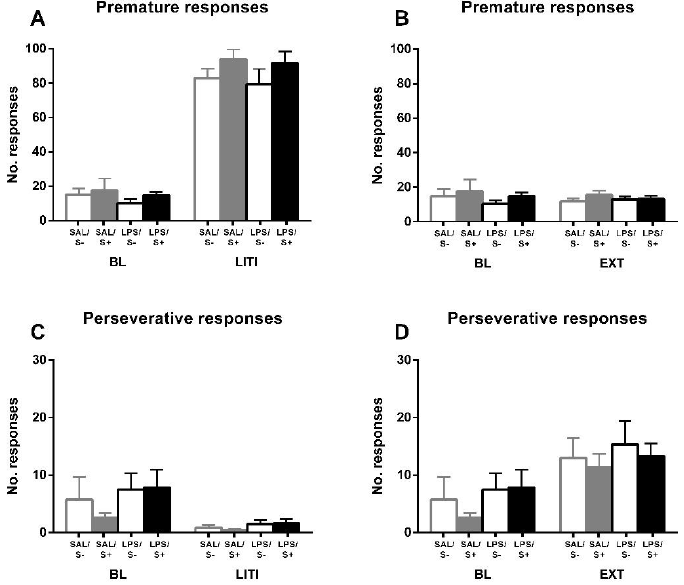
Figure 6. 5-CSRT task variables manipulations in saline-control (SAL/S-), LPS-control (LPS/S-), saline-stress (SAL/S+), or LPS-stress (LPS/S+) groups ( n = 12). Performance of animals is shown under long inter-trial interval (LITI) and extinction (EXT) conditions for premature ( A , B ) and perseverative ( C , D ) responses, compared to baseline (BL). As it was expected, the LITI condition significantly increases premature responses and decreases perseverative responses in all groups; extinction significantly increases perseverative responses in all groups without affecting premature responses. Data is represented as mean ± SEM.